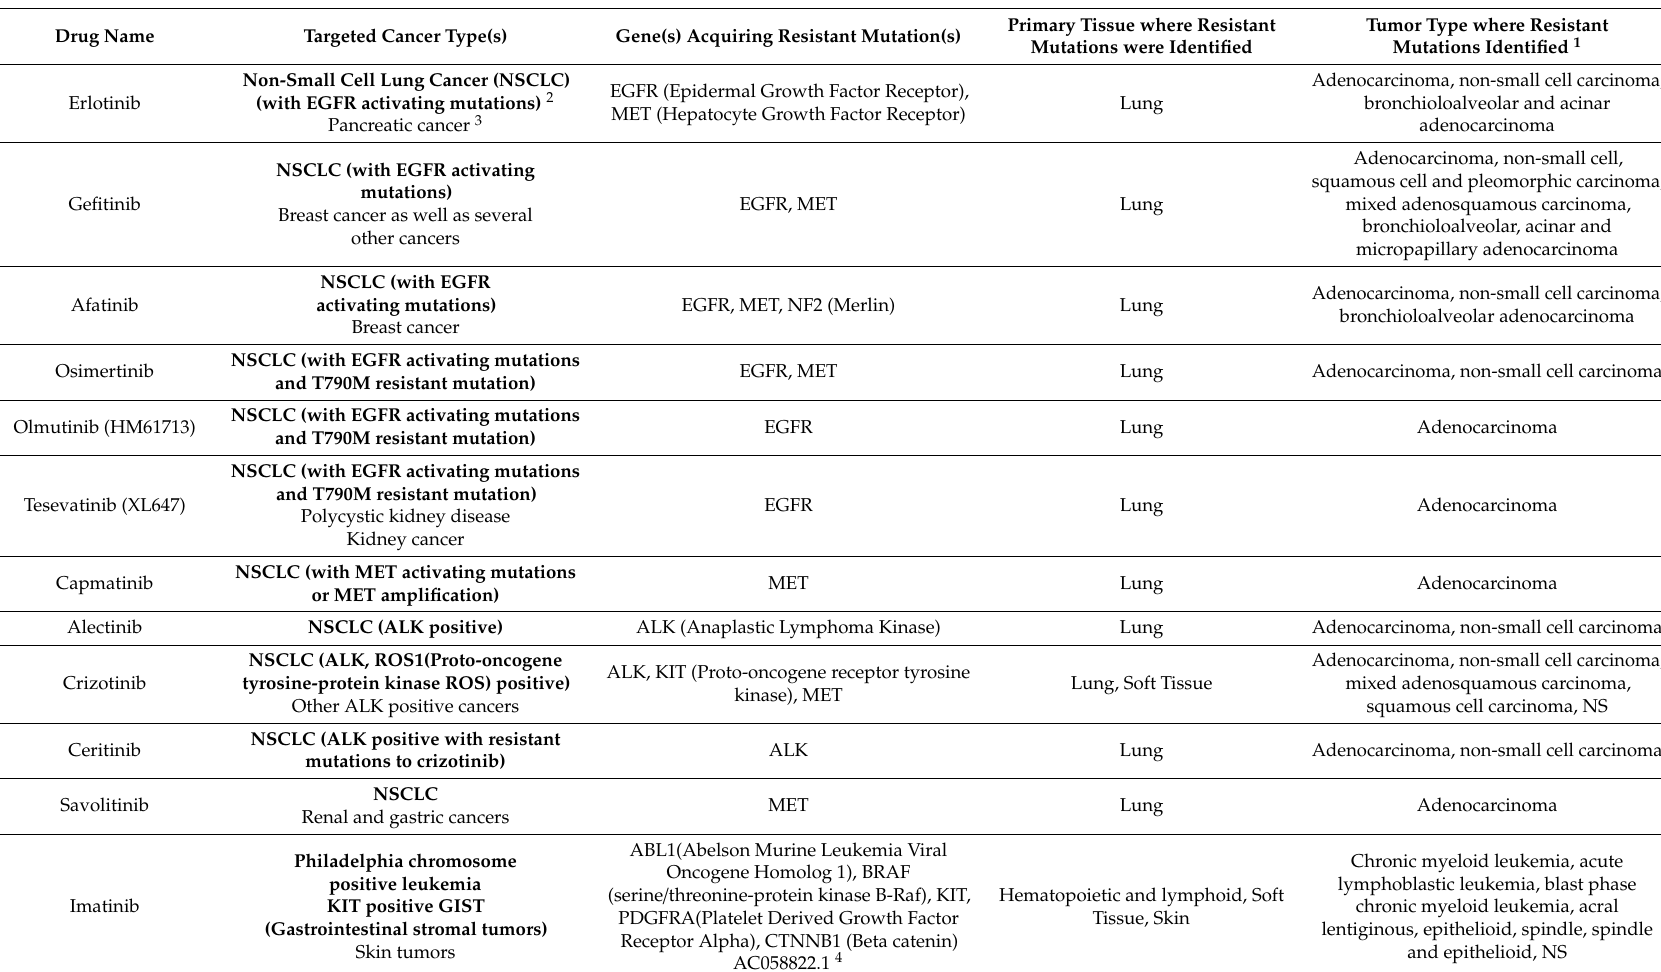
Table 1. Summary of secondary mutations acquired by various genes in response to small molecule